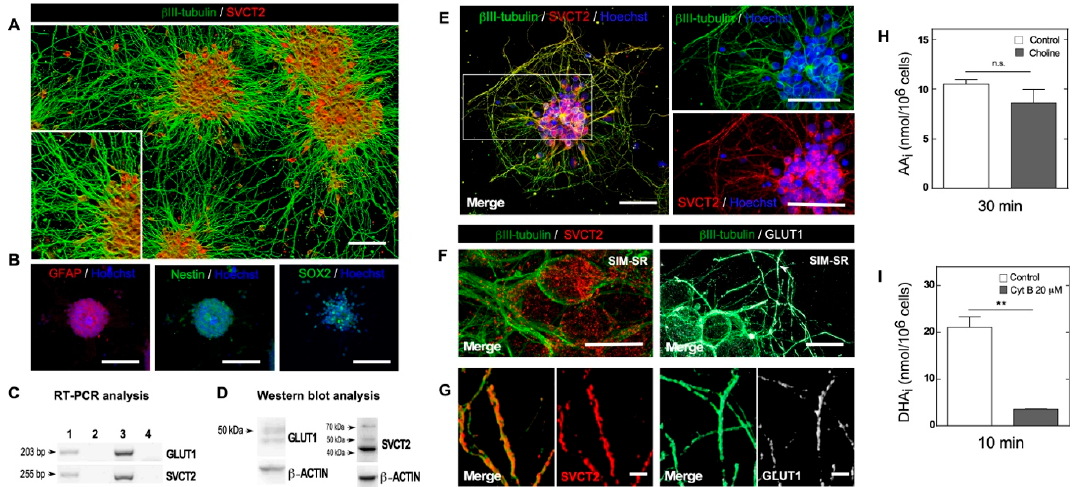
Figure 1. Adhered neurospheres showed SVCT2 expression mainly in di ff erentiated neuronal cells. ( A ) Confocal microscopy with tile-scan 3D and rendering analysis of NEs stained with anti-SVCT2 (red) and anti- β III tubulin (green). Inset. A detailed analysis of neurosphere processes. Scale bar, 100 µ m. ( B ) NE confocal microscopy analysis using antibodies against GFAP, nestin, and SOX2 and nuclear staining with Hoechst. Scale bar, 50 µ m. ( C ) PCR analysis of SVCT2 and GLUT1 mRNA. Line 1: cDNA obtained from control NEs adhered for 24 h. Line 2: Control reaction without reverse transcriptase. Line 3: Postnatal day 8 rat brain cDNA (positive control). Line 4: Negative control (water). ( D ) Western blot analysis with anti-GLUT1 and anti-SVCT2 antibodies in extracts of control NEs 24 h postadhesion. ( E ) Confocal microscopy and merge analysis using anti-SVCT2 (red) and anti- β III-tubulin (green) antibodies and nuclear staining with Hoechst. Right side. Digital zoom images of the depicted zone in E. Scale bar, 50 µ m. ( F ) SVCT2 and GLUT1 transporter detection by 3D-SIM superresolution (SIM-SR) microscopy analysis in control NEs adhered for 24 h. Left side. β III-tubulin (green) and SVCT2 (red) detection. Right side. β III-tubulin (green) and GLUT1 (white) detection. Scale bar, 10 µ m. ( G ) SVCT2 and GLUT1 transporter detection by SIM superresolution (SIM-SR) microscopy analysis in control NEs adhered for 24 h. Left side. Digital magnification of β III tubulin / SVCT2 positive processes. Right side. Digital magnification of β III tubulin / GLUT1 positive processes. Scale bar, 2 µ m. ( H ) AA uptake in NEs adhered (24 h, control) in the presence or absence of sodium. All data are representative of three separate experiments. Parametric Student’s t -test, n.s., not significant. ( I ) DHA uptake analysis in NEs adhered (24 h, control) in the absence or presence of 20 µ M cytochalasin B (GLUT1 inhibitor). All data are representative of three separate experiments.